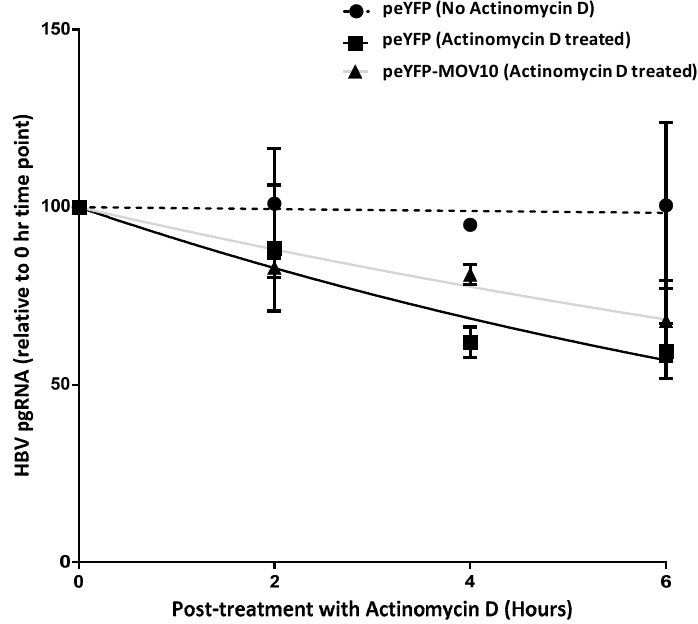
Figure 8. MOV10 over-expression does not induce the degradation of HBV pgRNA. 293T cells were transfected with HBV core-deficient plasmid (Cp-deficient pHBV) and peYFP-MOV10 or peYFP-empty (eYFP) plasmids. After 48 h, the cells were treated with 5 µg/mL Actinomycin D. The cells were harvested at 0, 2, 4, 6 h after Actinomycin D treatment. Total RNA was extracted and HBV pgRNA levels were determined relative to the 0 h time point. RPL18A mRNA was used as a normalization control. Single phase decay curves are shown. The dotted line represents cells transfected with Cp-deficient pHBV and peYFP in the absence of Actinomycin D. The solid black line represents cells transfected with Cp-deficient pHBV and peYFP in the presence of Actinomycin D. The grey line represents cells transfected with Cp-deficient pHBV and peYFP-MOV10 in the presence of Actinomycin D. Data represent mean ± standard deviation from two independent experiments.